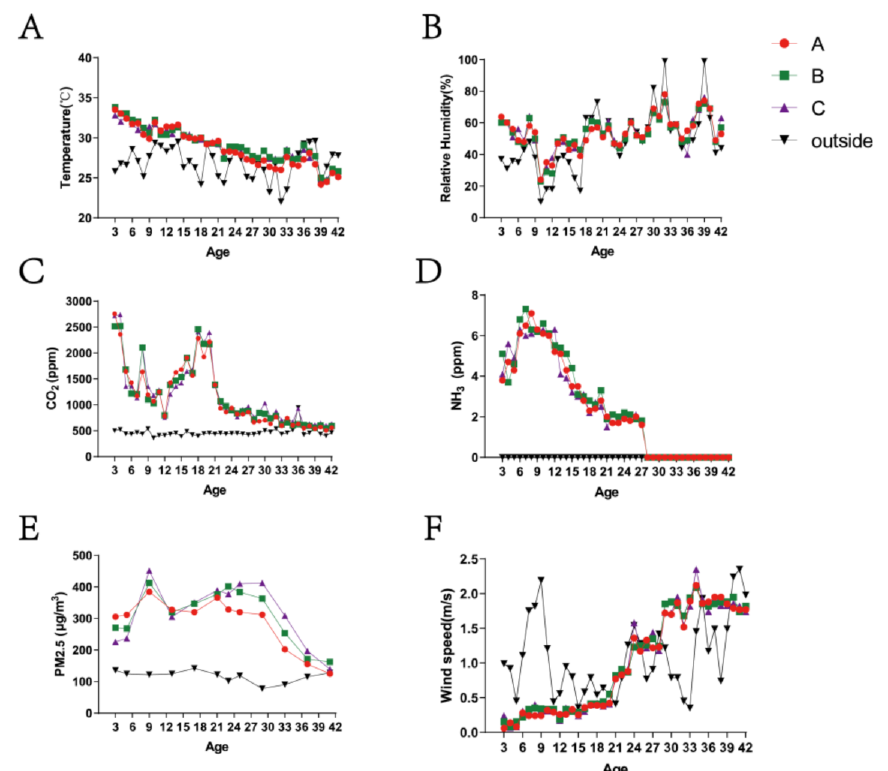
Figure 2. Variations in environmental control variables and PM2.5 concentrations inside and outside the cage-house. ( A ) Temperature ( ◦ C); ( B ) relative humidity (%); ( C ) CO 2 (ppm); ( D ) NH 3 (ppm); ( E ) PM2.5 (ug/m 3 ); ( F ) wind speed (m/s). Legend: A, B, and C in the upper right corner represent the adoption points of three broiler houses.